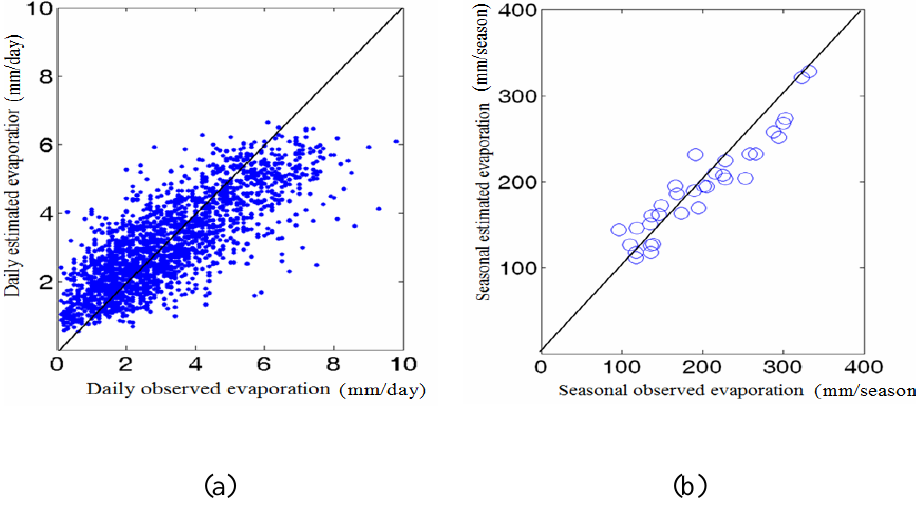
Fig. 8. Scatter plots of AK estimation versus observations in testing phase: (a) in daily scale; and (b) in seasonal scale. 538